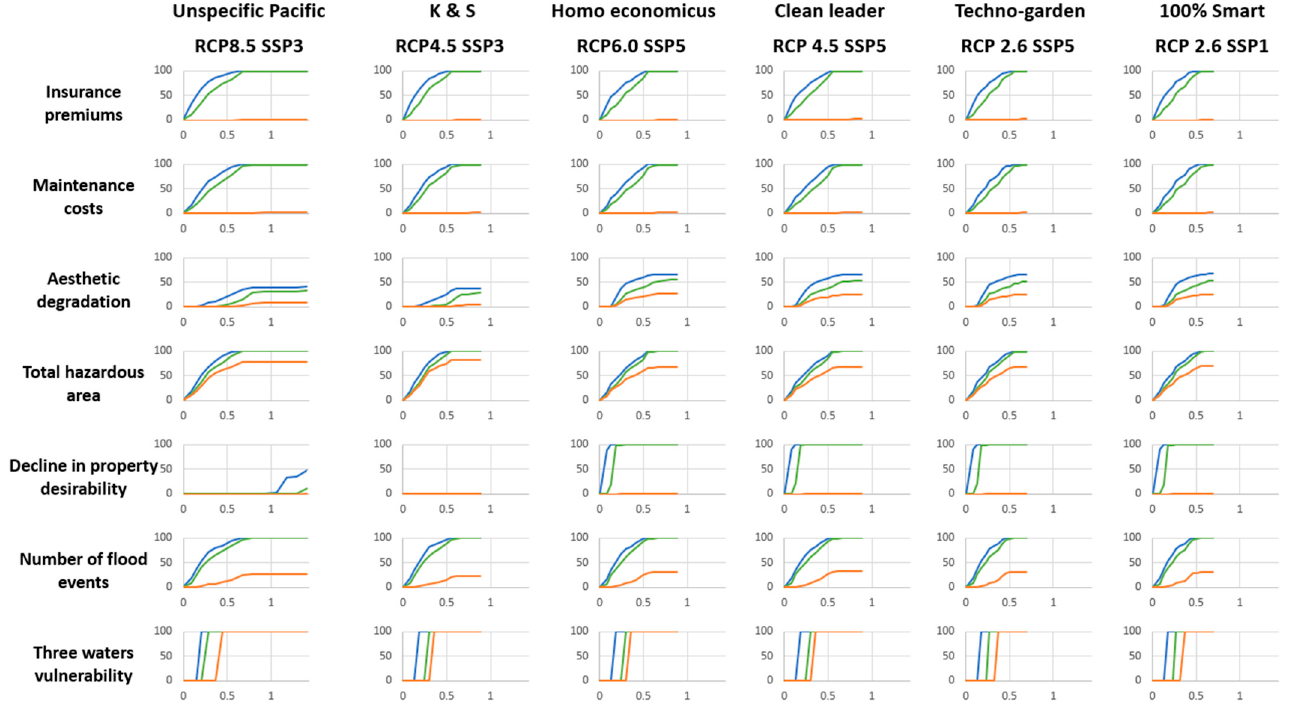
Figure 6. Activation time of signals, triggers and adaptation thresholds for the seven indicator variables. For this and Figure 7, Y axis shows percentage of active signals, triggers and adaptation thresholds out of 2500 Monte Carlo simulations for each SSP/RCP scenario, X axis shows level of RSLR. Blue line indicates active signals, green line indicates active triggers, orange line indicates adaptation thresholds breached. ‘K & S’ is scenario Kicking and screaming.